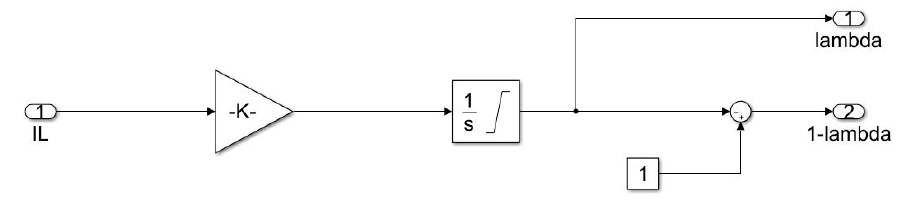
Figure 3. Block diagram for lambda calculation (Simulink model).